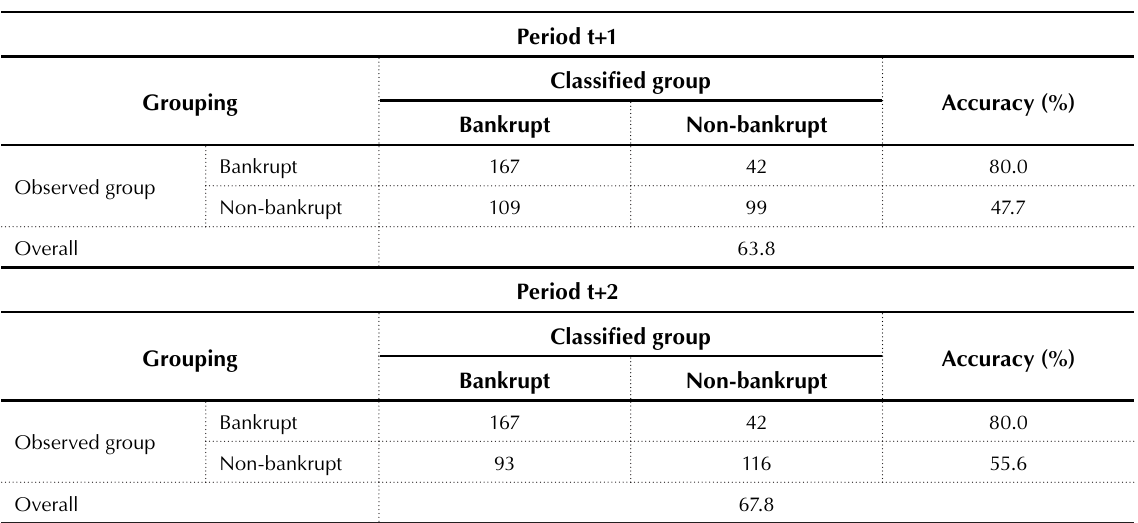
Table 4. Classification accuracies of logistic regression models for periods t+1 and